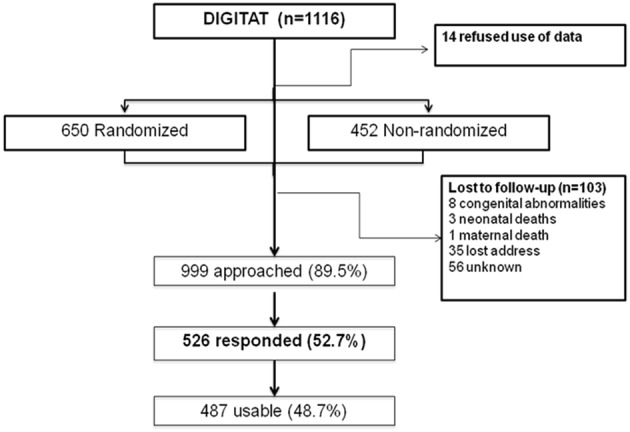
Flowchart of trial participants.